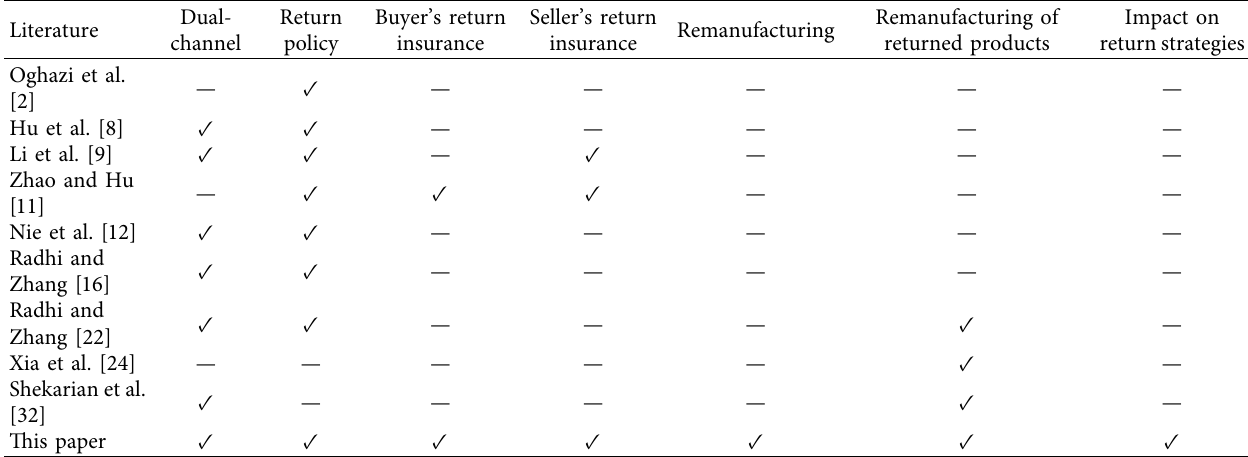
Table 1: Comparison among recent relevant